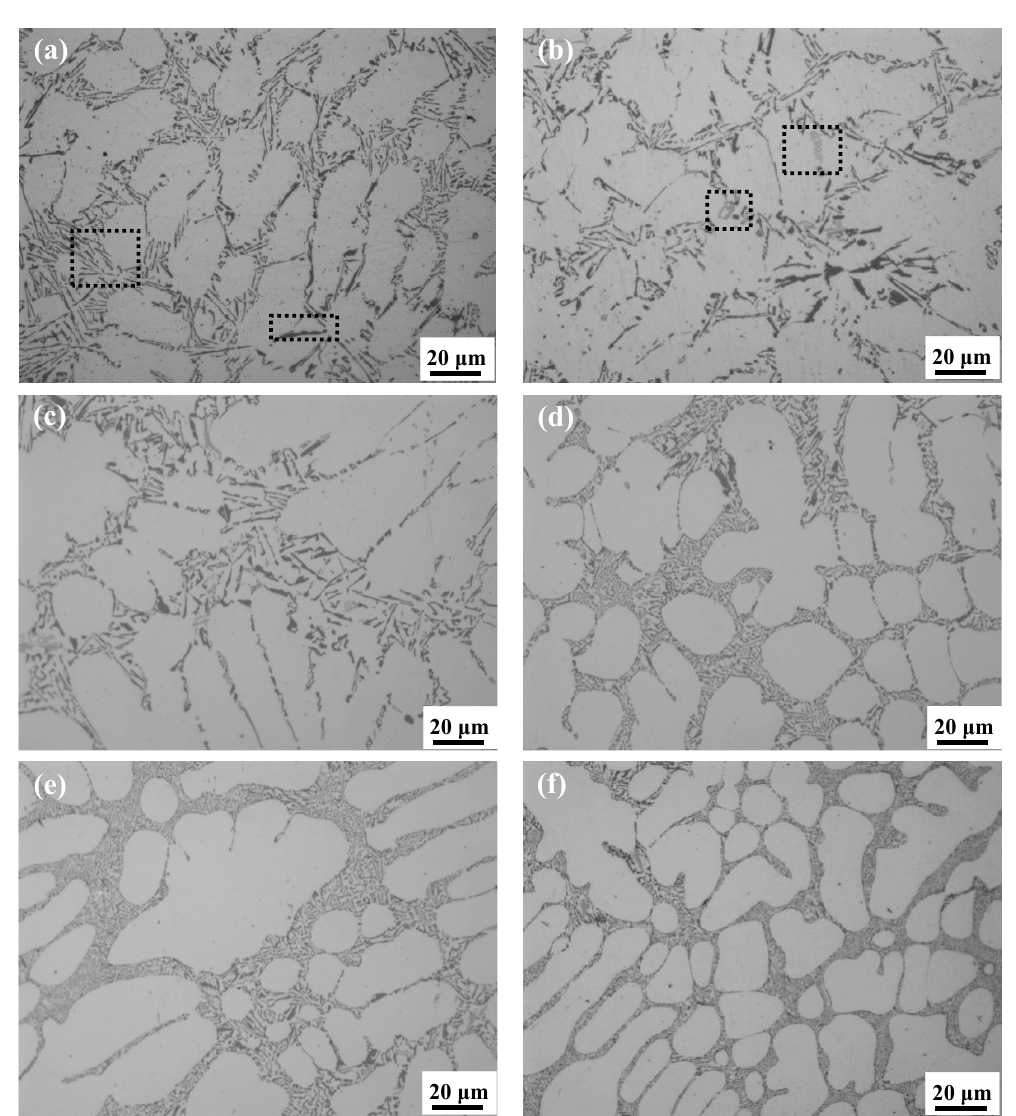
Figure 1. Optical microstructures of Al-8Si alloy ingots ( a ) without Mg and with ( b ) 0.33% Mg, ( c ) 0.51% Mg, ( d ) 0.78% Mg, ( e ) 0.99% Mg, and ( f ) 1.32% Mg.